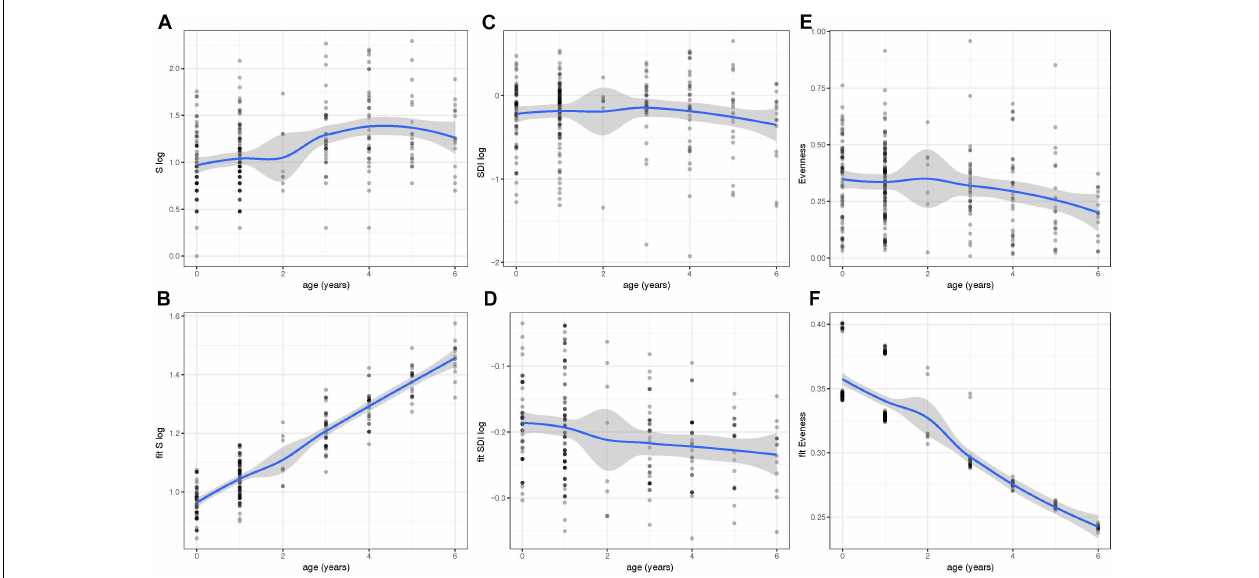
FIGURE 2 | Within-community diversity [Richness (S), Shannon Diversity Index (SDI) and Evenness] analysis in different age groups. Values of S (A) , SDI (C) , and Evenness (E) were obtained at different ages (0–6 years of age). However, the residuals of the models for S and SDI were not normally distributed and, therefore, were log transformed (A–D) . To correct for the dependency nature of the study, linear mixed models including fixed effects were also done and fitted values of S (B) , SDI (D) , and evenness (F) were plotted throughout time. Richness and Evenness values reveal an increase and decrease in older children, respectively. Fitted values were obtained using the lme4 R package and plots were generated using